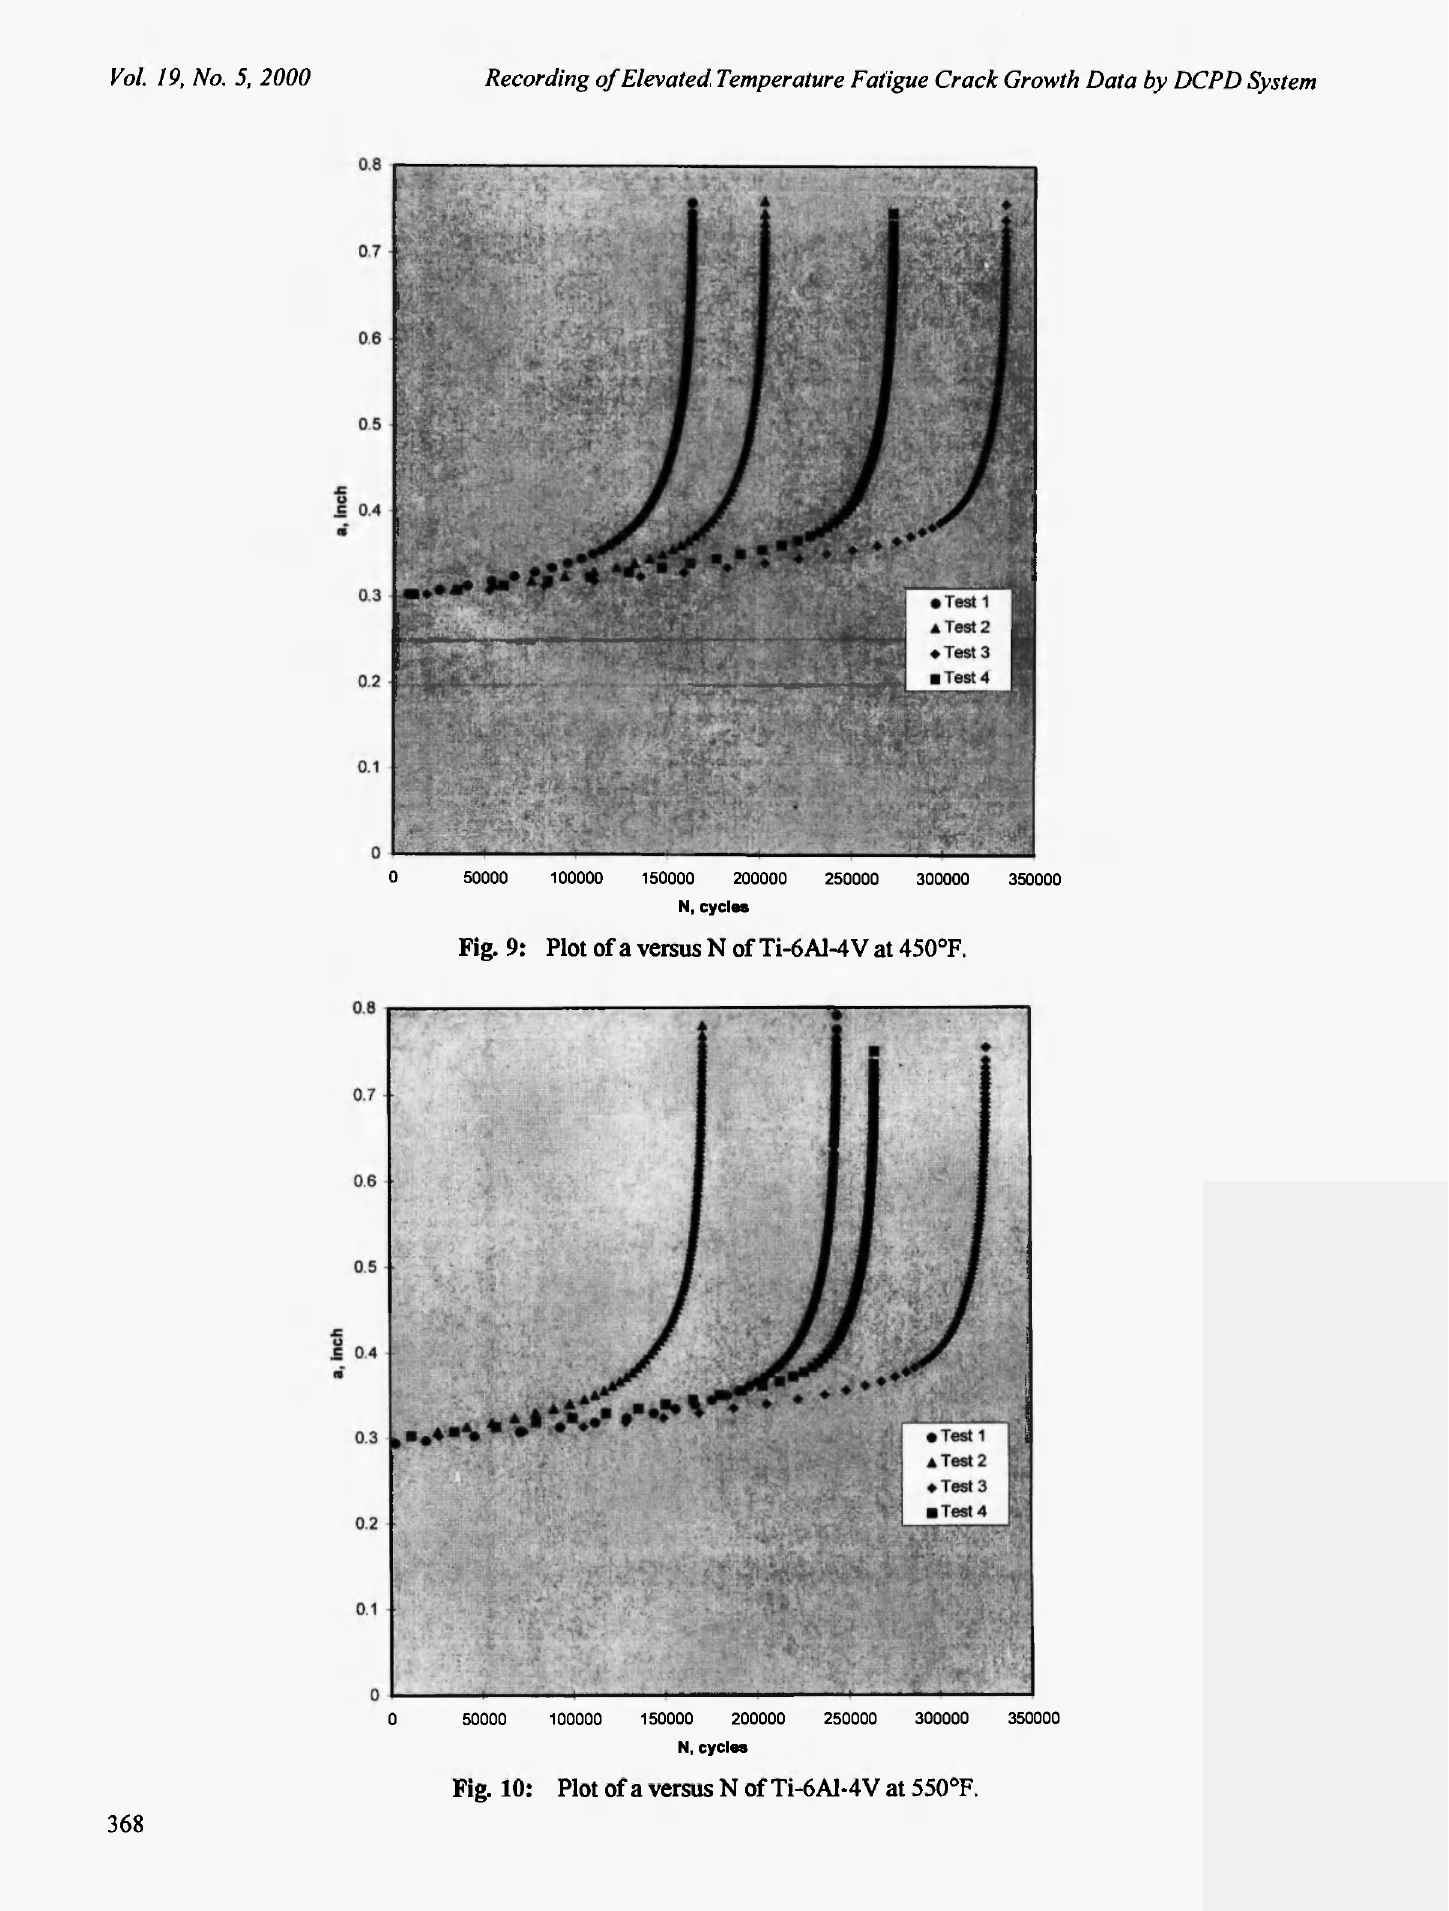
Fig. 10: Plot of a versus Ν of ΤΪ-6Α1-4 V at